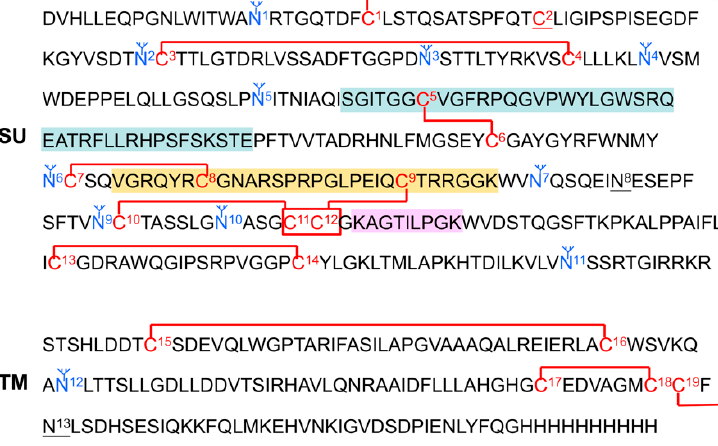
Figure 3. The proposed secondary structure of the subgroup A to E ASLV envelope glycoproteins. Shown are the disulfide bonds determined using a His-tagged, secreted form of the RCASBP(A) envelope glycoprotein expressed using chicken DF-1 cells and purified. The bonds to C11 and C12 (indicated with a box) could not be assigned further. The free cysteine is labeled C2. The N-linked glycosylation sites actually containing carbohydrate are marked in blue. The unglycosylated sites are underlined, N8 and N13. For reference, the hypervariable regions are marked: hr1 in green boxes; hr2 in an orange box; and vr3 in a pink box.